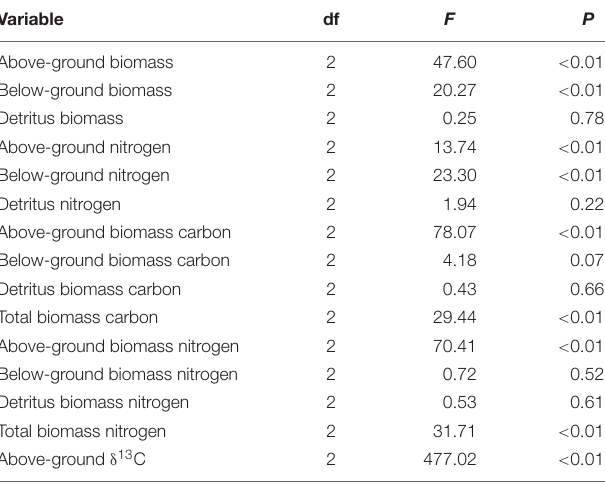
TABLE 2 | Statistical analysis of effects of different light intensities on seagrass parameters.